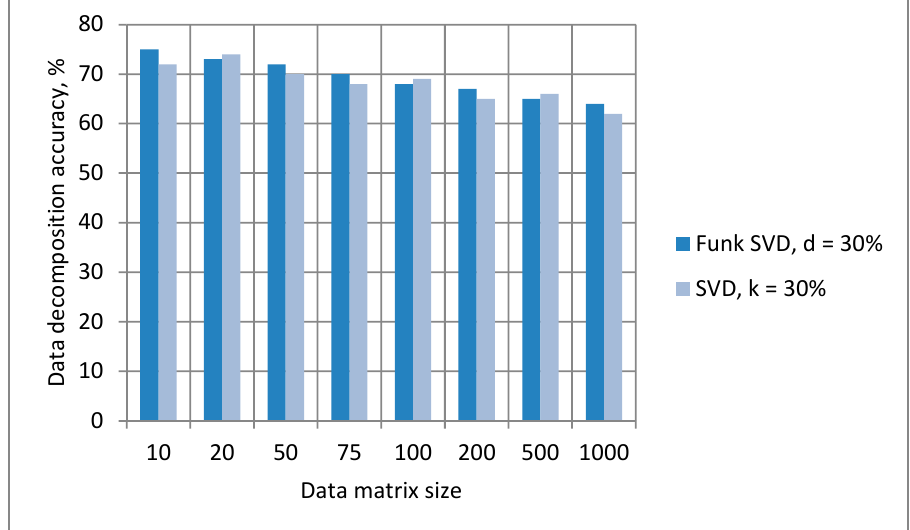
Figure 5. Data decomposition accuracy comparison for the SVD and Funk SVD algorithms.